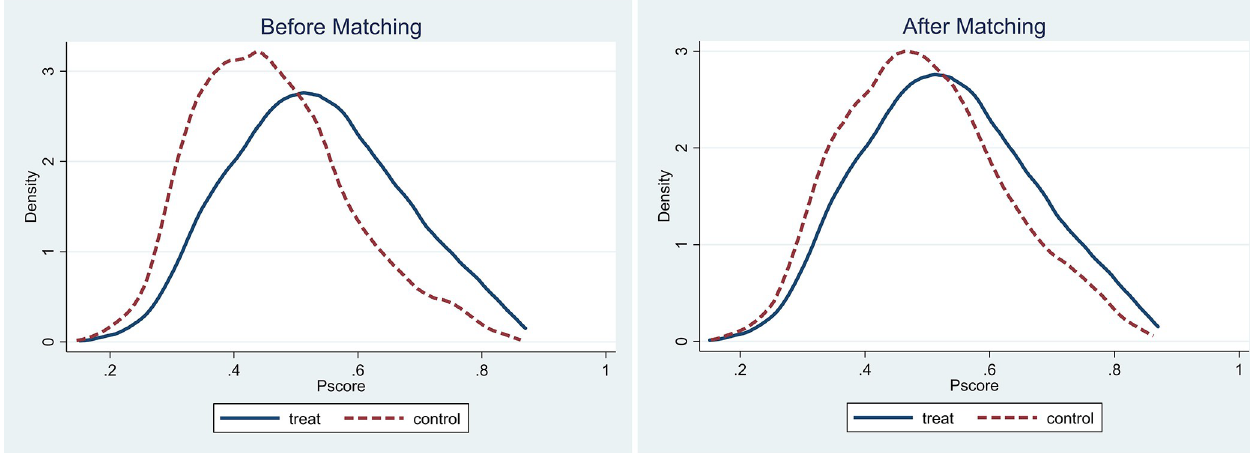
Fig 2. Propensity score distribution before and after matching. (a) Before matching (b) After matching.